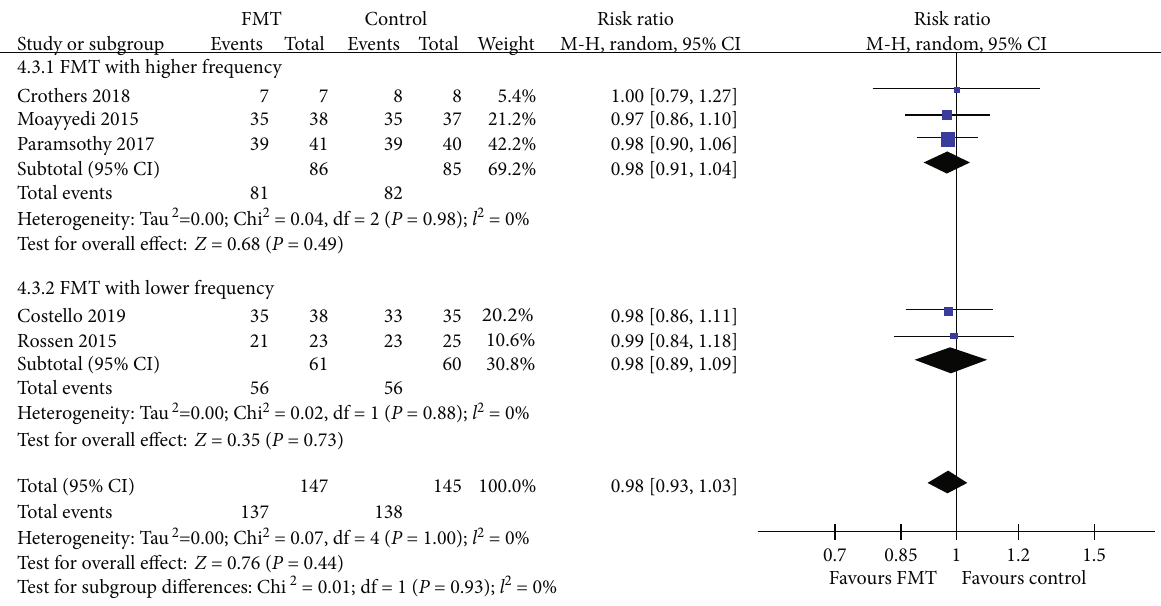
Figure 14: Forest plot of studies reporting serious adverse events and subgroup analysis according to frequency of FMT